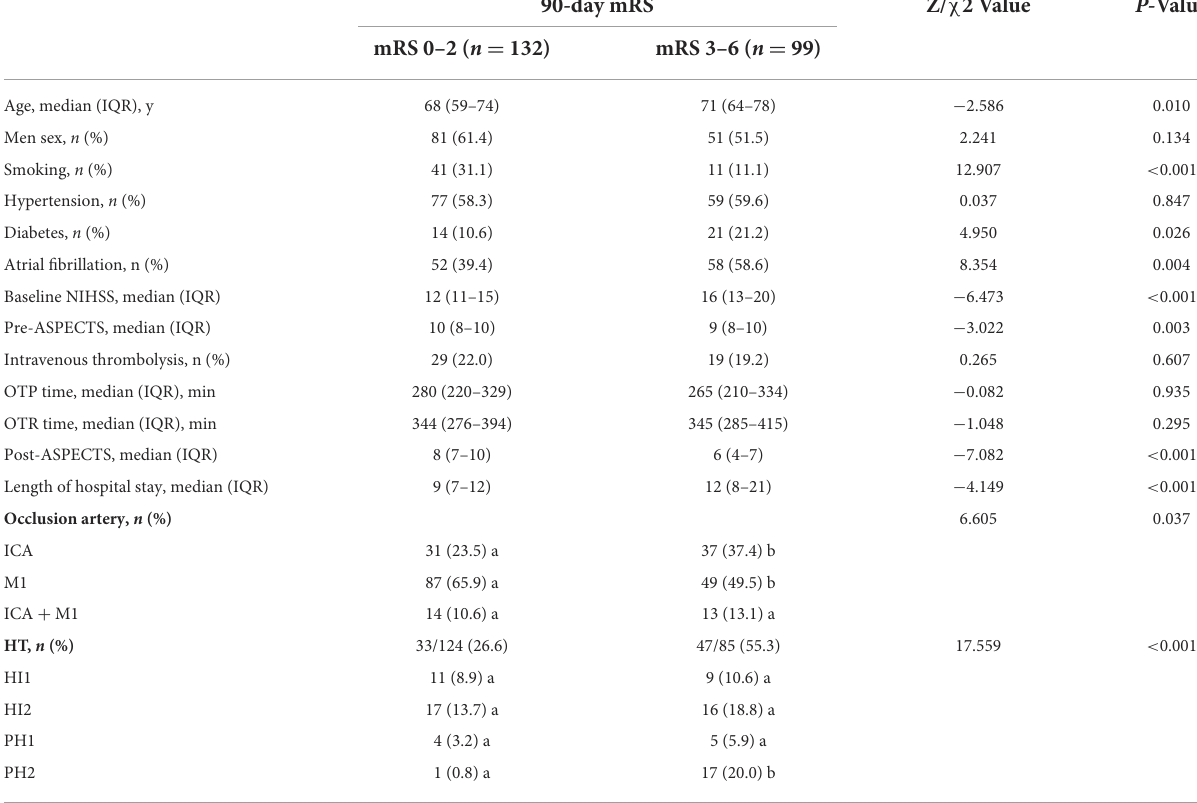
TABLE 1 Comparison of the good prognosis group with the poor prognosis group at the 90-day follow-up.